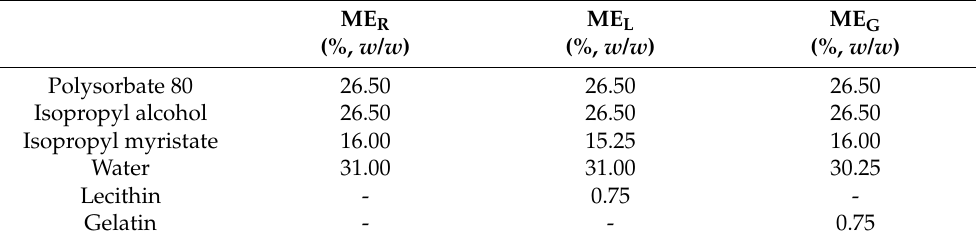
Table 1. The Composition of the Microemulsions—Reference Microemulsion (ME R ), Lecithin- Containing Microemulsion (ME L ), Gelatin-Containing Microemulsion (ME G ) .